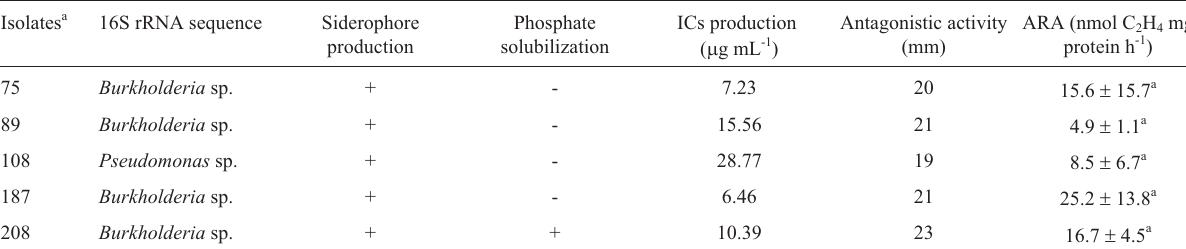
Table 3 - Identification and PGP abilities of the selected isolates. Isolates a 16S rRNA sequence